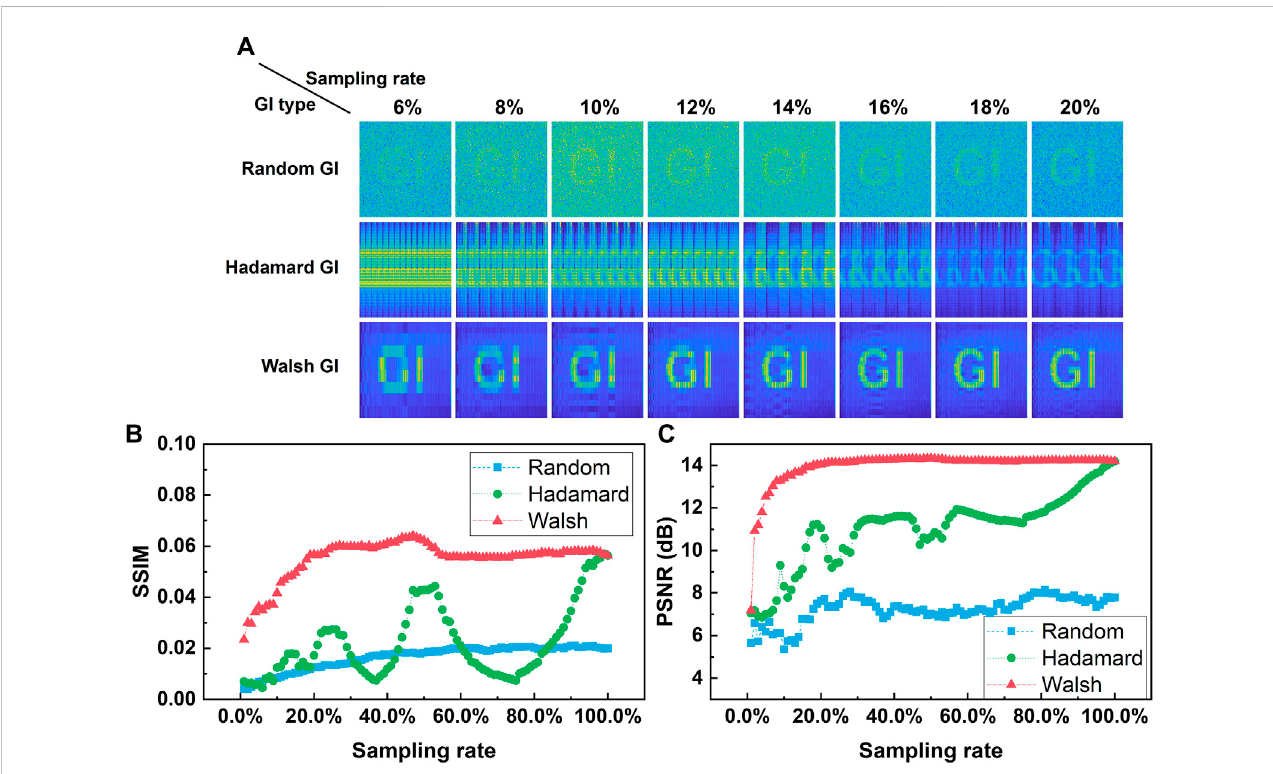
FIGURE 7 (A) Experimental results of laser GI based on random speckle patterns, Hadamard speckle patterns, and Walsh speckle patterns in the air. (B) SSIM indicator and (C) PSNR indicator vs sampling rates of laser GI based on random, Hadamard, and Walsh speckle patterns in the air.